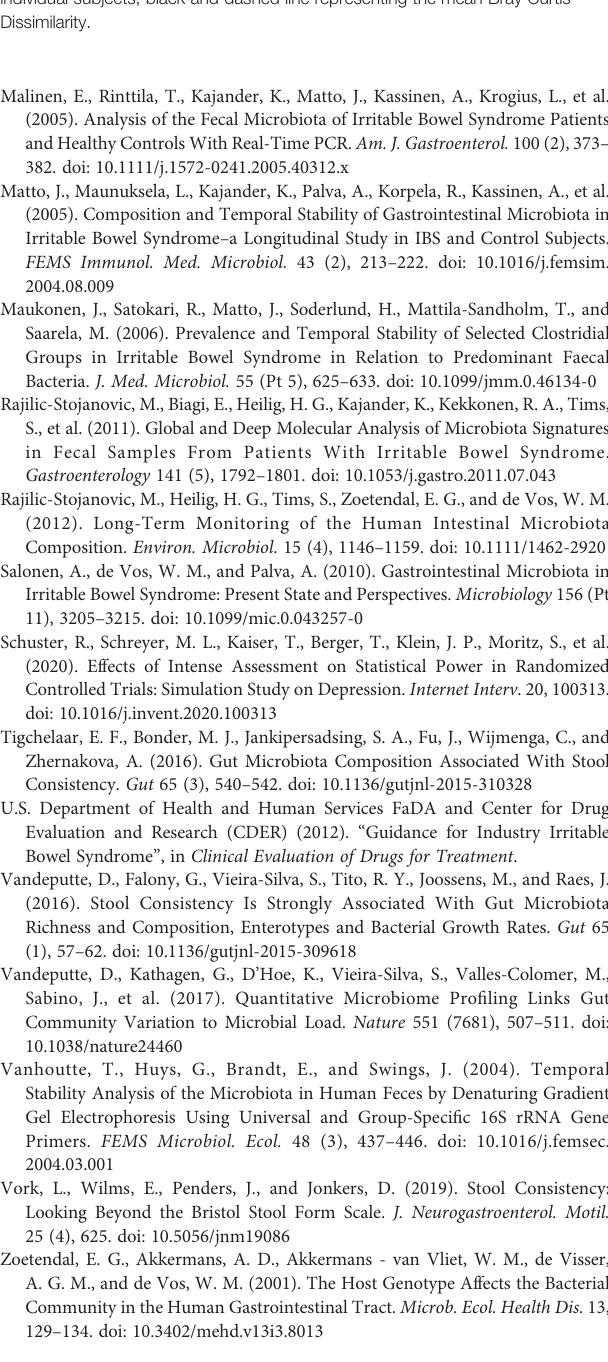
Regression coef fi cient indicates the direction and strength of the association between the predictor and dependent variable. Supplementary Figure 1 | Stool consistency for each sample and separately for all subjects ( i.e. each color represents a subject), measured by fecal dry weight percentage (A) and Bristol Stool Scale (B) . Supplementary Figure 2 | Overview of the microbial composition of IBS and healthy subjects based on relative abundances on the phylum level. Supplementary Figure 3 | Relative abundances for healthy subjects vs. IBS patients, signi fi cance tested using Mann Whitney U test. ** p < 0.01, NS , Not